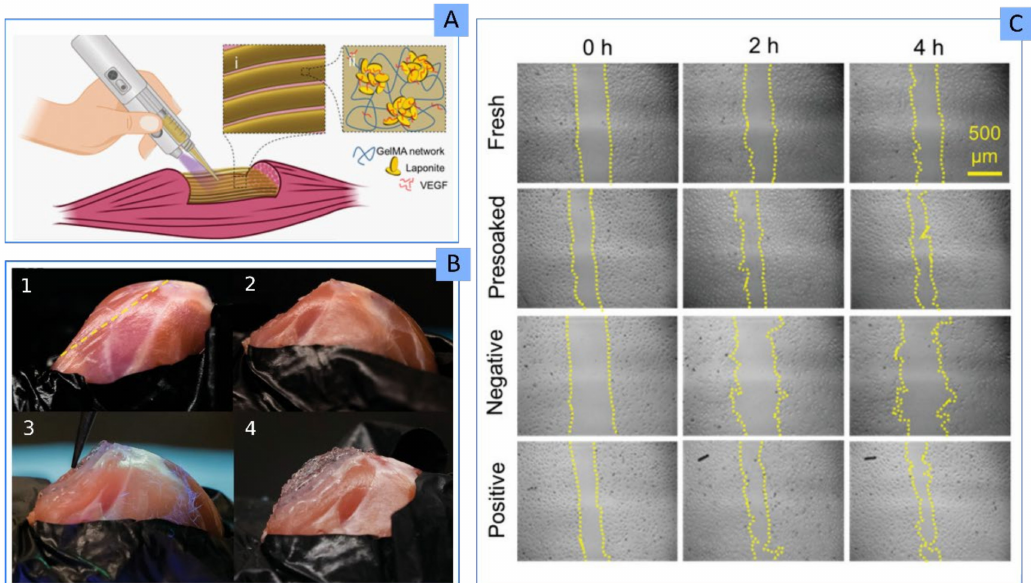
Figure 21. ( A ) In vivo handheld printing device aspect and composition of GelMA-LAP BMI, loaded with VEGF. The aim of this BI and the handheld device was to treat skeletal muscle injuries through in situ 3D printing. ( B ) Photographs of muscle-induced injury. Step 3 shows the handheld printing process, and Step 4 shows the finished restoration surgery. ( C ) Optical microphotographs of scratch assay with HUVEC cells. “Fresh” results belonged to GelMA-LAP/VEGF BMI crosslinked and subjected to scratch assay at time 0; “Presoaked” scratch assay was performed with crosslinked GelMA- LAP/VEGF BMI pre-soaked in DPBS for 24 h before scratch assay; “Negative” control was composed of growth medium without VEGF; “Positive” control test was performed by means of growth medium supplemented with 30 ng/mL of VEGF. Figures adapted with permission from [63], IOP Publishing,